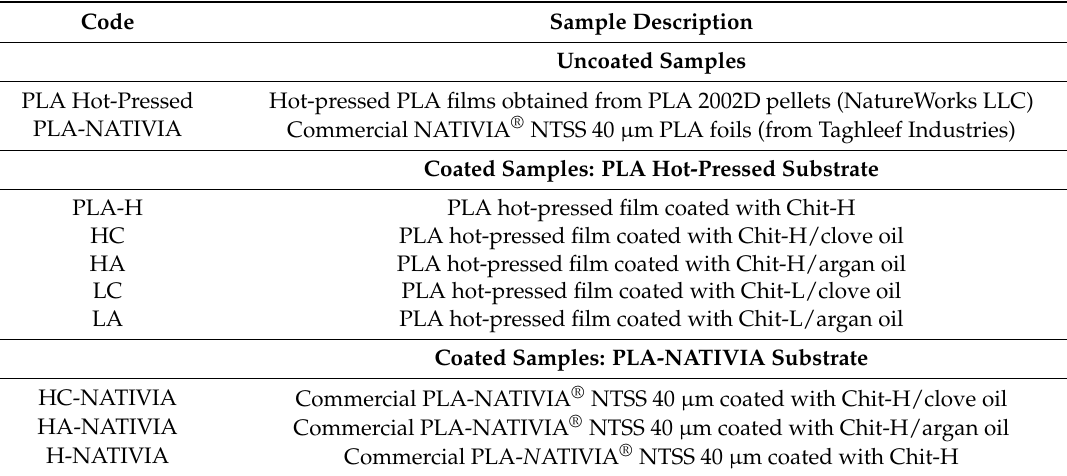
Table 1. PLA samples uncoated and coated with chitosan and clove oil or argan oil, using the electrospinning